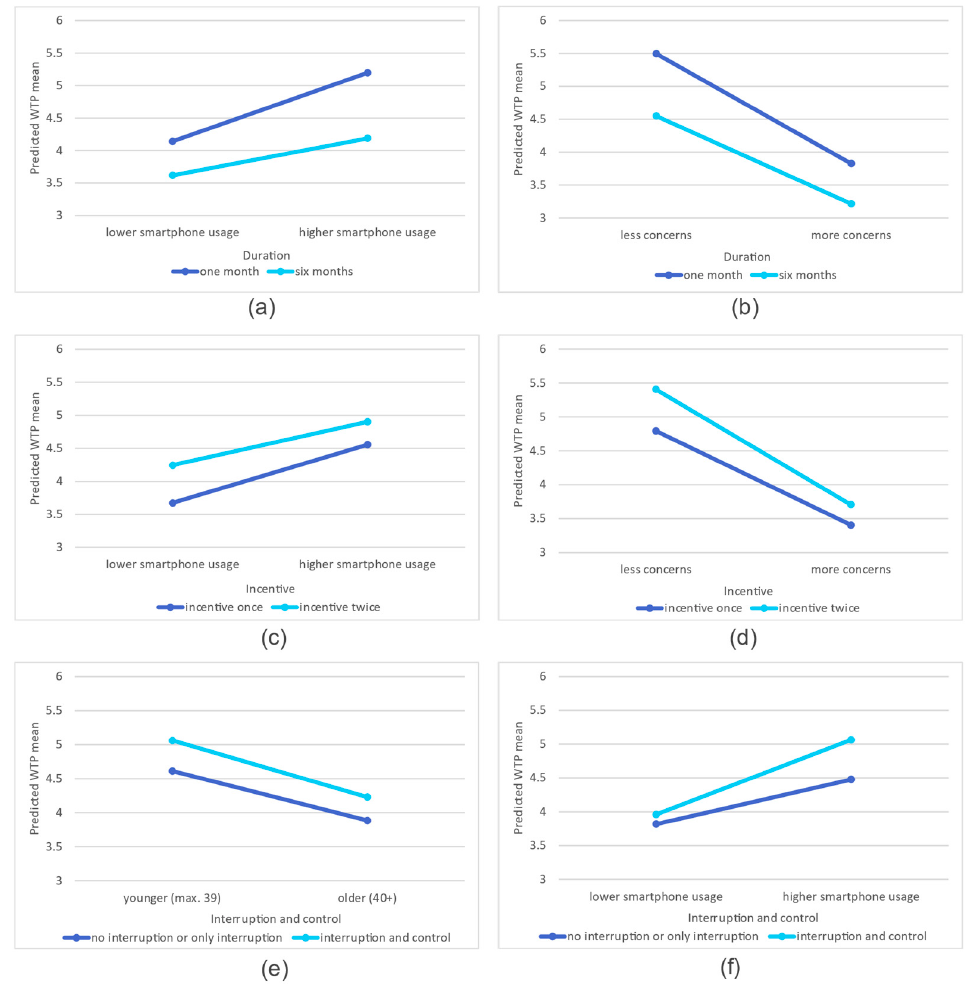
Figure 1. Predicted values of cross-level interactions. ( a ) Length of study with smartphone usage. ( b ) Length of study with concerns overs passive data collection. ( c ) Number of incentives with smartphone usage. ( d ) Number of incentives with concerns over passive data collection. ( e ) Interruption and control with age. ( f ) Interruption and control with smartphone usage.